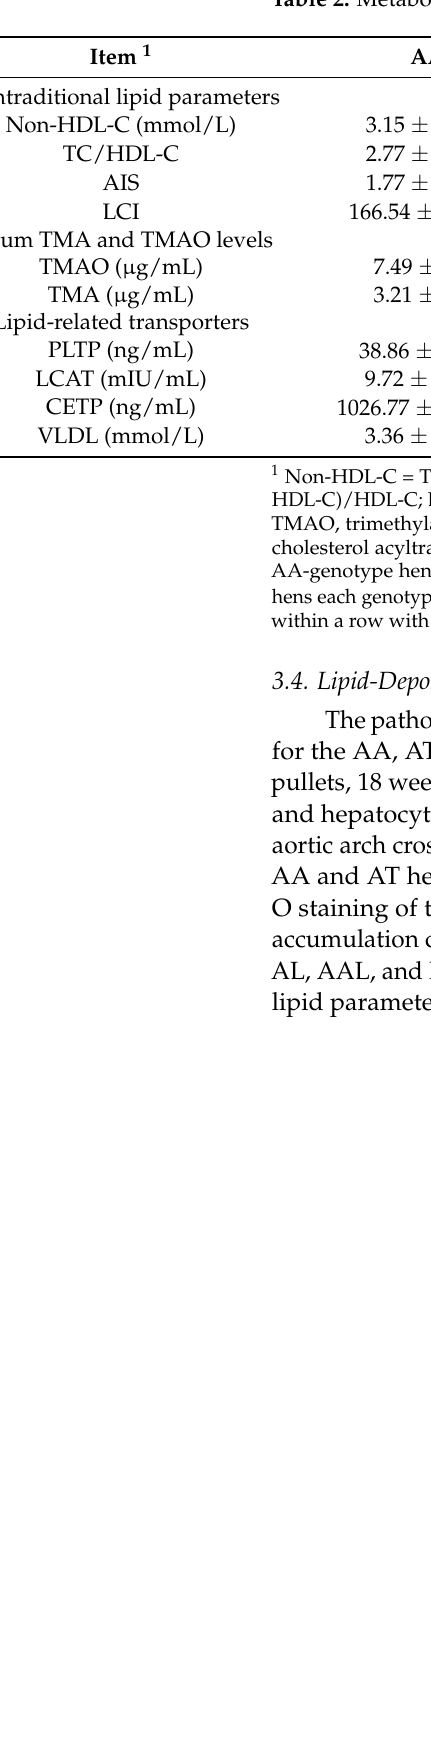
Table 2. Metabolic characteristics of laying hens at the age of 62